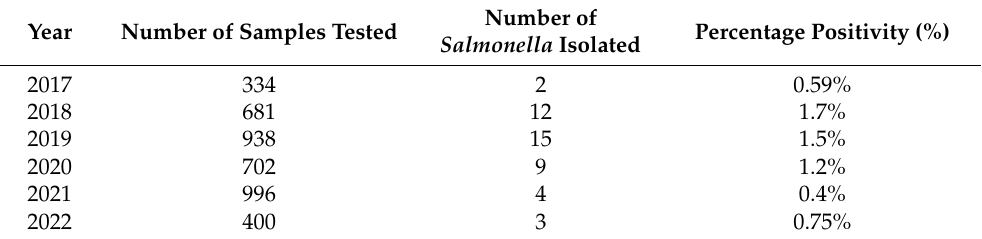
Table 1. The number of Salmonella spp. that were isolated against the number of total samples that were tested in each year from 2017 to June 2022, with the percentage of positivity.